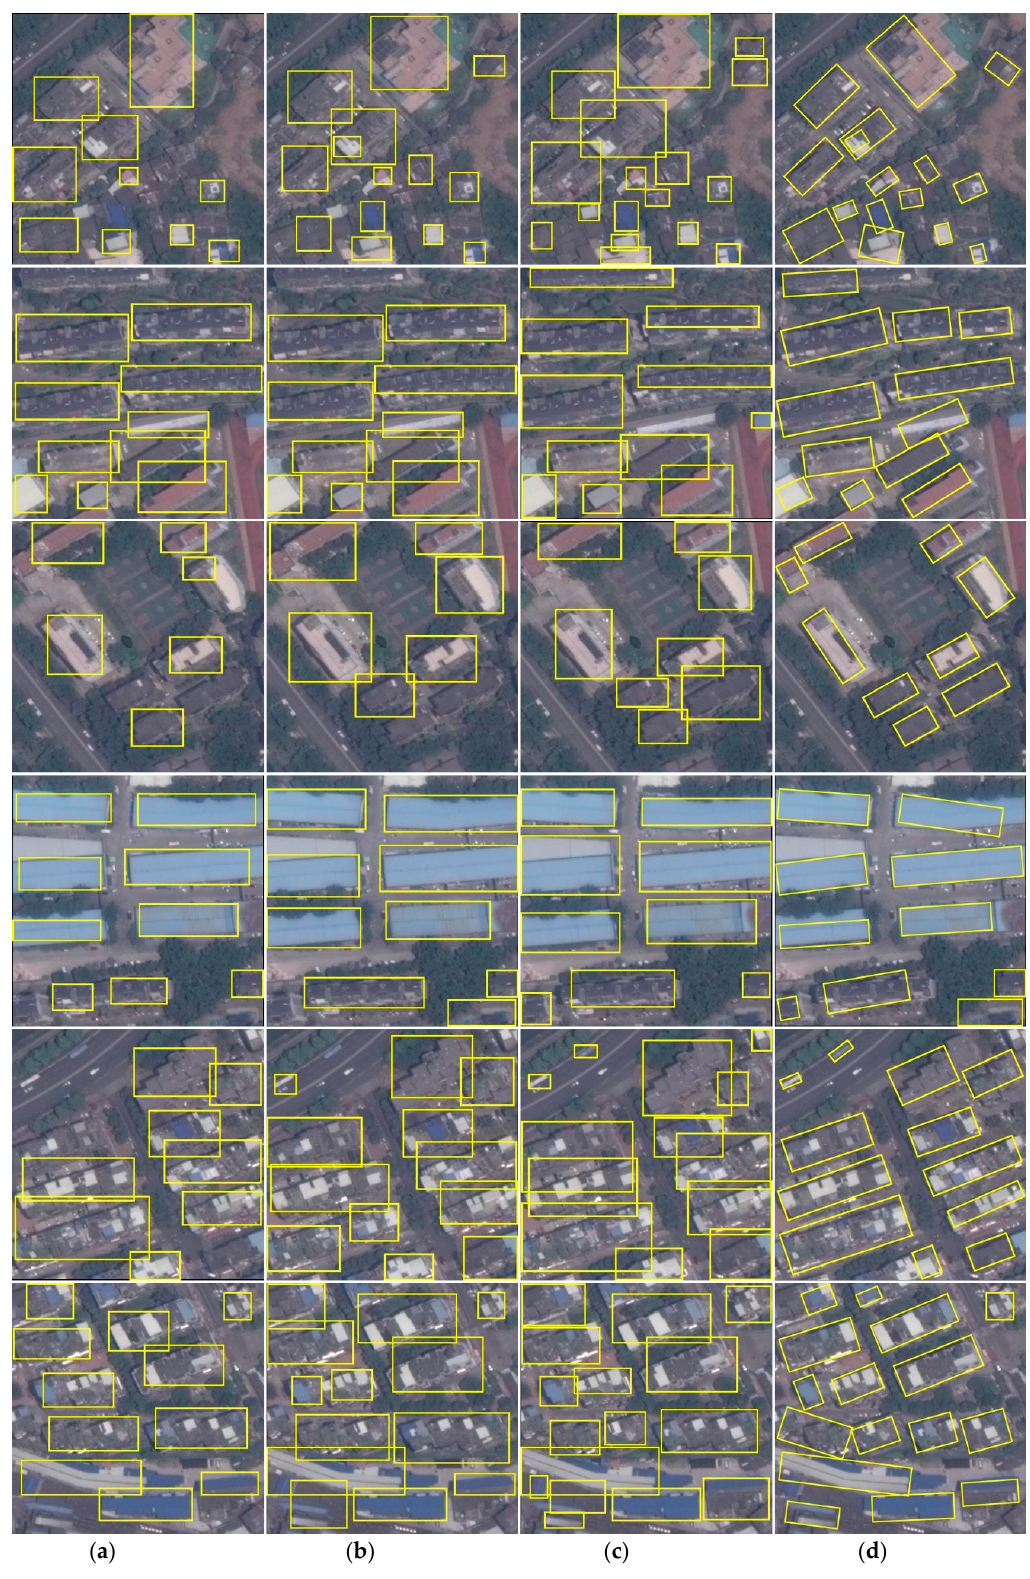
Figure 8. Comparison with other methods. ( a ) Faster R-CNN-VGG; ( b ) Faster R-CNN-ResNet101; ( c ) Mask R-CNN-ResNet101; ( d ) the proposed method.